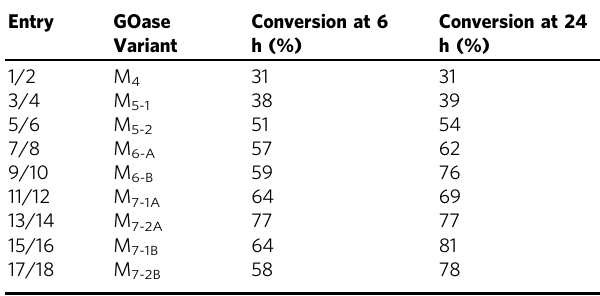
Table 6 Conversion of 100 g/L semi-crude HMF to DFF by GOase